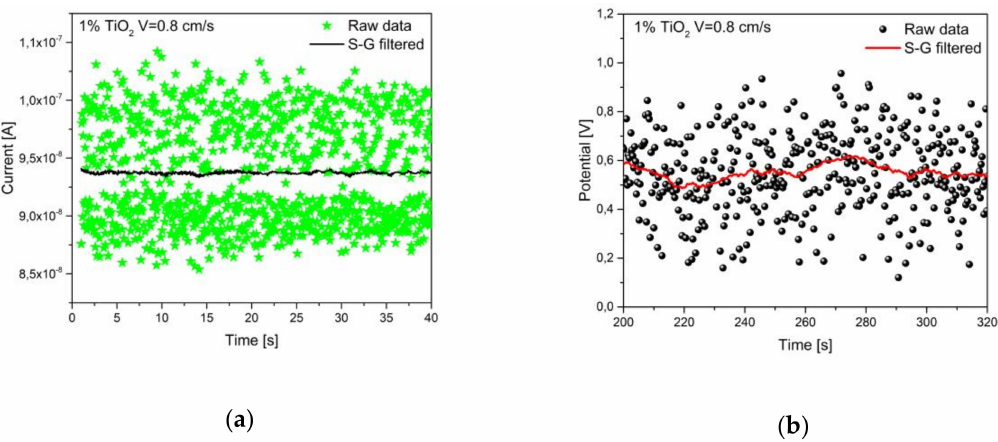
Figure 4. I ( a ) and V ( b ) measurements in time (1% titania suspension, 0.8 cm / s speed). Comparison between raw and filtered data.